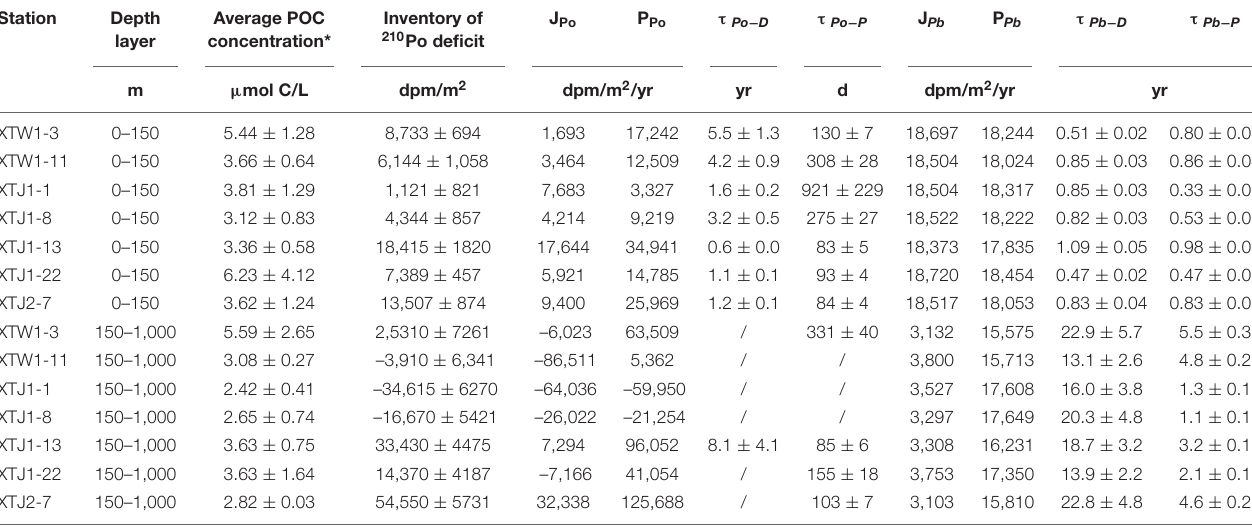
TABLE 1 | Model calculations of the scavenging rates (J) and removal fluxes (P) for 210 Po and 210 Pb, together with the particulate and dissolved residence times in the surface and deeper layers in the